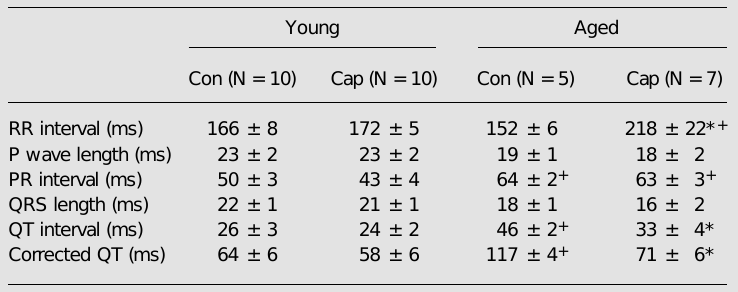
Table 3. Number (mean ± SEM) of supraventricular (SVPB) and ventricular premature beats (VPB) in conscious male young and aged rats treated (Cap) or not (control, Con) with captopril.